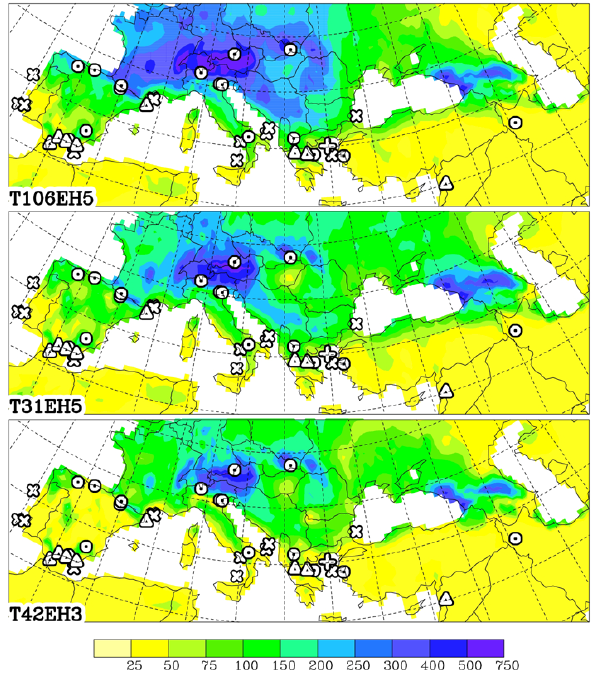
Fig. 7. Summer precipitation during the LGM down-scaled to a 0.5 ◦ grid. Contours at 25, 50, 75, 100, 150, 200, 250, 300, 400, 500mmseason − 1 . Sites with observed summer-green tree growth during the LGM are indicated by markers. Circles: only cold- tolerant trees (continental), triangles: cool or warm-loving trees (continental), Xs: only cold-tolerant trees (marine), crosses: cool or warm-loving trees